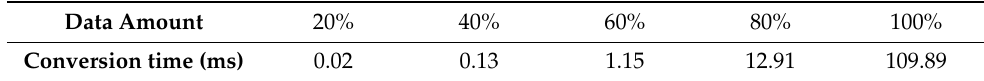
Table 8. Coding conversion time